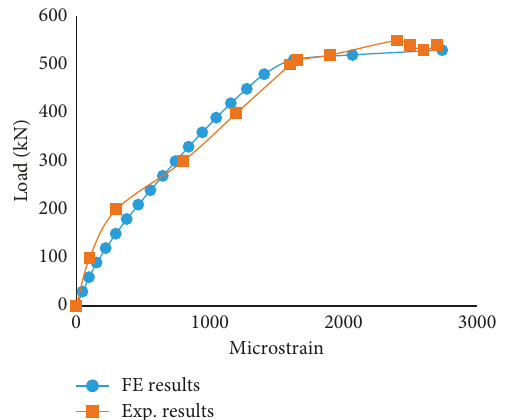
Figure 8: Strain curve (strain gauge 2) of steel